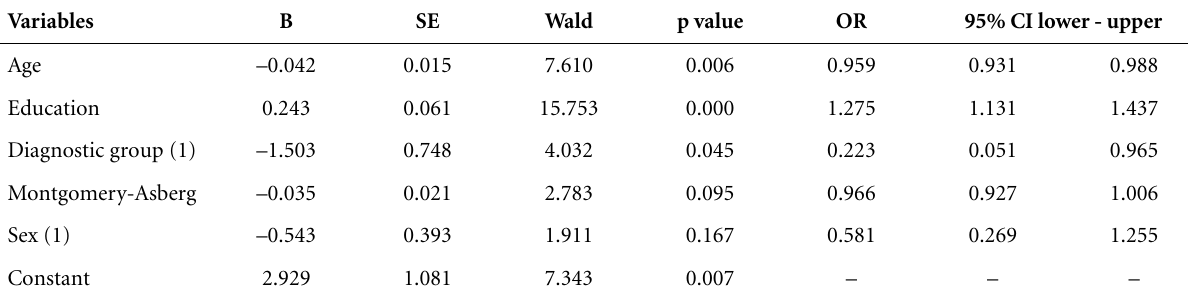
Table 5. Final model of the logistic regression for cognitive impairment as the